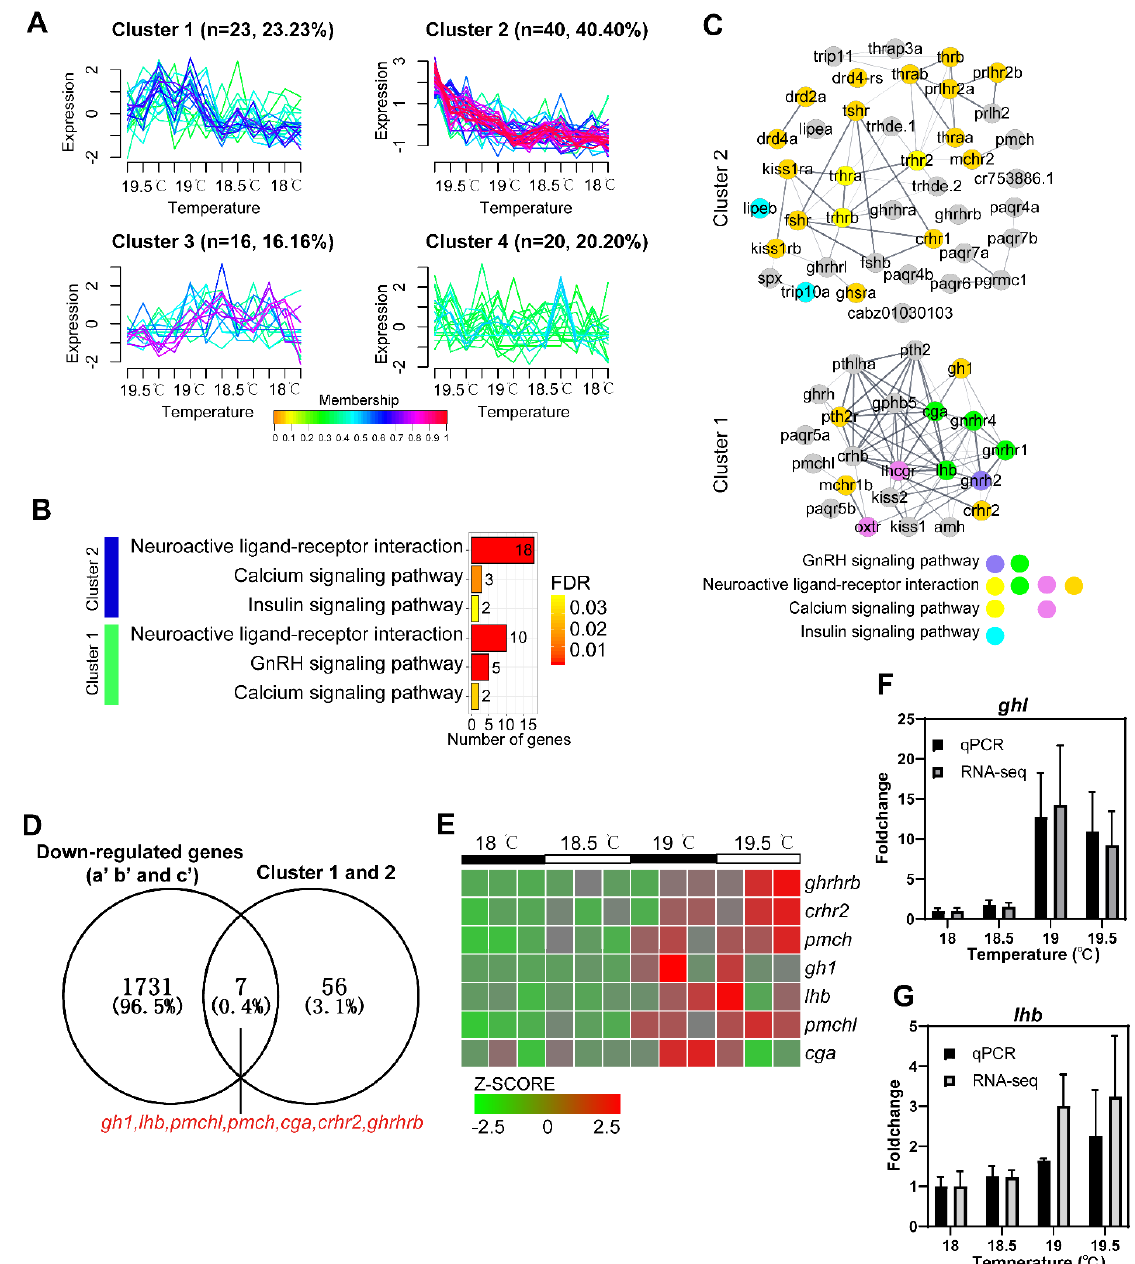
Figure 7. Details of hormone − related genes detected in the female zebrafish brains by RNA − seq. ( A ) Clustering analysis of hormone − related genes. ( B ) Bar plot of pathway enrichment analysis of genes in cluster 1 and cluster 2. False discovery rate (FDR) < 0.05. ( C ) Protein − protein interaction network of genes in cluster 1 and cluster 2. Nodes represent genes; edges stand for relationship of different genes; different color means different signaling pathways as shown at the bottom. ( D ) Venn diagram was used to identify down-regulated key genes that were shared in the group of down- regulated genes (a’, b’ and c’) and cluster 1 and 2. ( E ) Heat map of seven down-regulated key genes, presented as the normalization of TPM (z − score). ( F , G ) Fold changes and SEM of RNA − seq and qPCR for two representative down-regulated key genes gh1 and